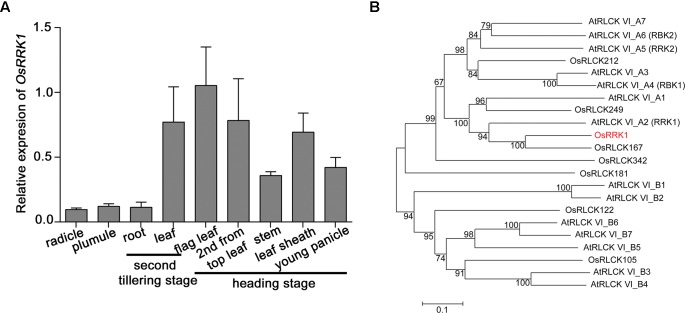
Characterization of the OsRRK1 gene. (A) Expression of OsRRK1 in various organs determined by qRT-PCR analysis. Rice ACTIN1 gene was used as an internal control. Error bars represent the SD of transcript levels determined from three independent replicates. (B) Phylogenetic analysis of OsRRK1 and its homologous protein with other RLCK VI sub-family members in Arabidopsis and rice by MEGA6.0 constructed using the Neighbor-Joining method. The OsRRK1 protein is shown in red. The GenBank accession numbers of OsRRK1 and its homologous proteins are as follows: OsRRK1: XP_015642177.1; OsRLCK212: XP_015642870.1; OsRLCK249: XP_015648938.1; OsRLCK167: XP_015634276.1; OsRLCK342: ABA95043.1; OsRLCK181: XP_015640273.1; OsRLCK122: XP_015632245.1; OsRLCK105: XP_015630796.1; AtRLCK VI_A1: NP_001078762.1; AtRLCK VI_A2: NP_179479.1; AtRLCK VI_A3: NP_201356.2; AtRLCK VI_A4: NP_568231.1; AtRLCK VI_A5: NP_198445.1; AtRLCK VI_A6: NP_001327889.1; AtRLCK VI_A7: NP_197392.2; AtRLCK VI_B1: NP_198595.1; AtRLCK VI_B2: NP_001321968.1; AtRLCK VI_B3: NP_001190918.1; AtRLCK VI_B4: NP_179266.2; AtRLCK VI_B5: NP_201199.1; AtRLCK VI_B6: NP_001319394.1; AtRLCK VI_B7: NP_173578.2.